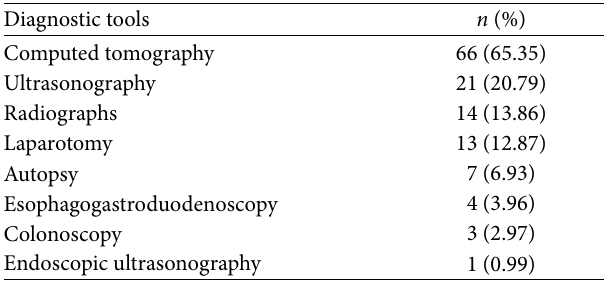
Table 2: Diagnostic tools used for imaging foreign bodies.